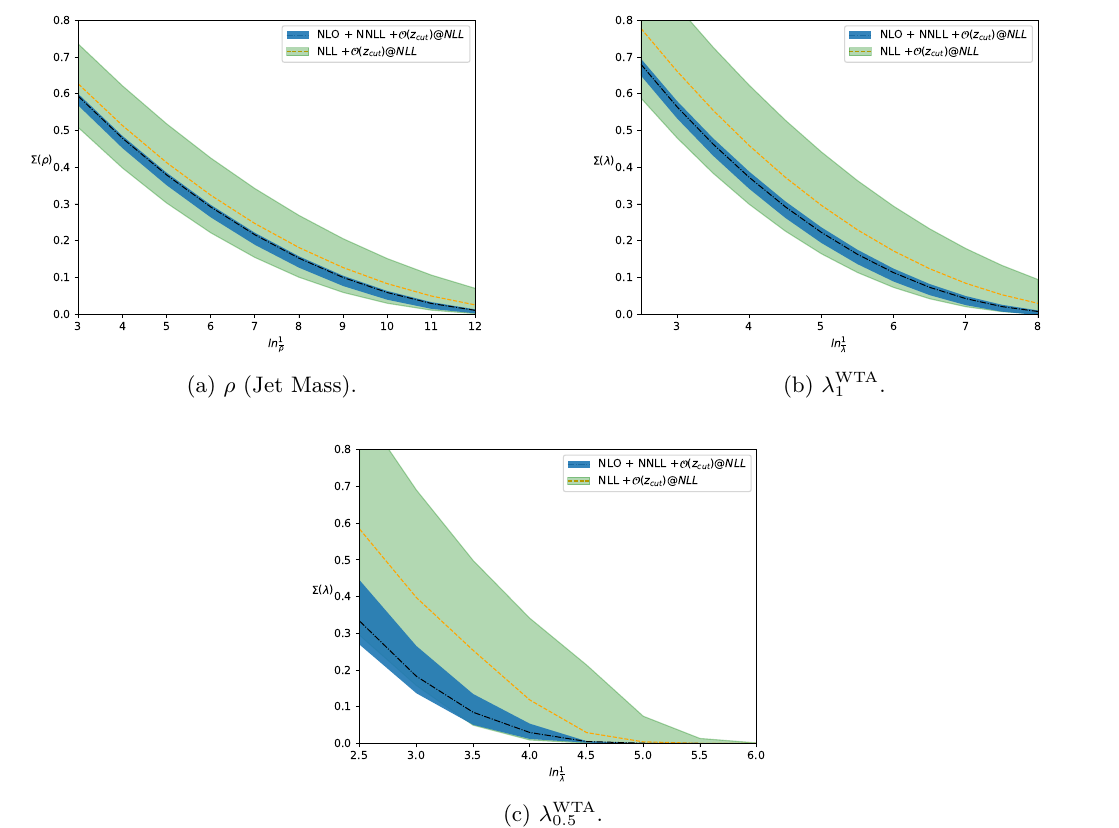
Figure 6. Matched NNLL predictions alongside the NLL result, both with finite z cut effects showing the central values and uncertainty